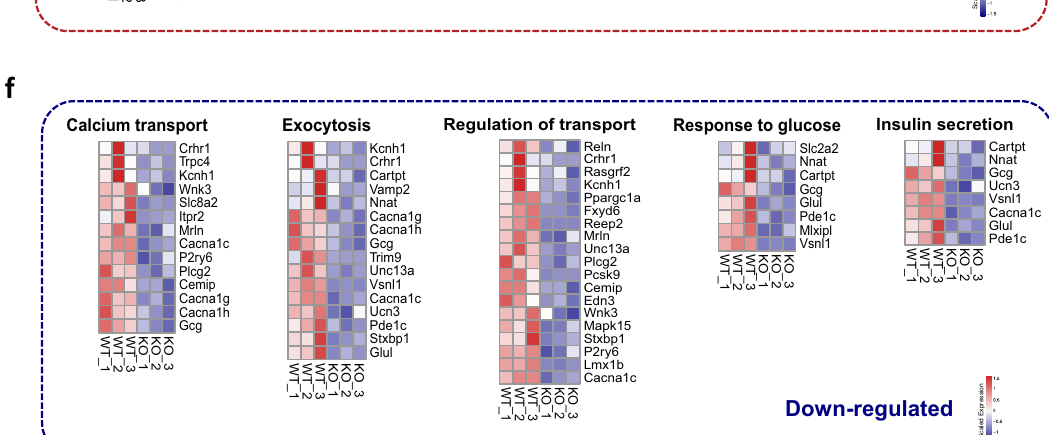
NATURE COMMUNICATIONS| (2022) 13:3545